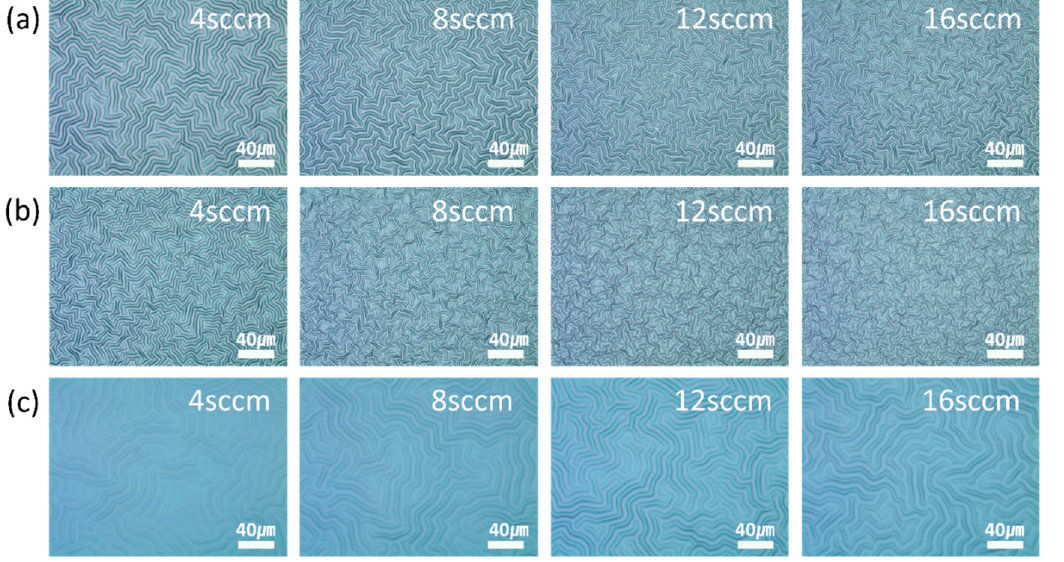
Figure 6. OM images of the wrinkles generated at different gas flow rates. ( a ) Nitrogen, ( b ) oxygen, and ( c ) argon plasma treatments were used to generate these wrinkles.